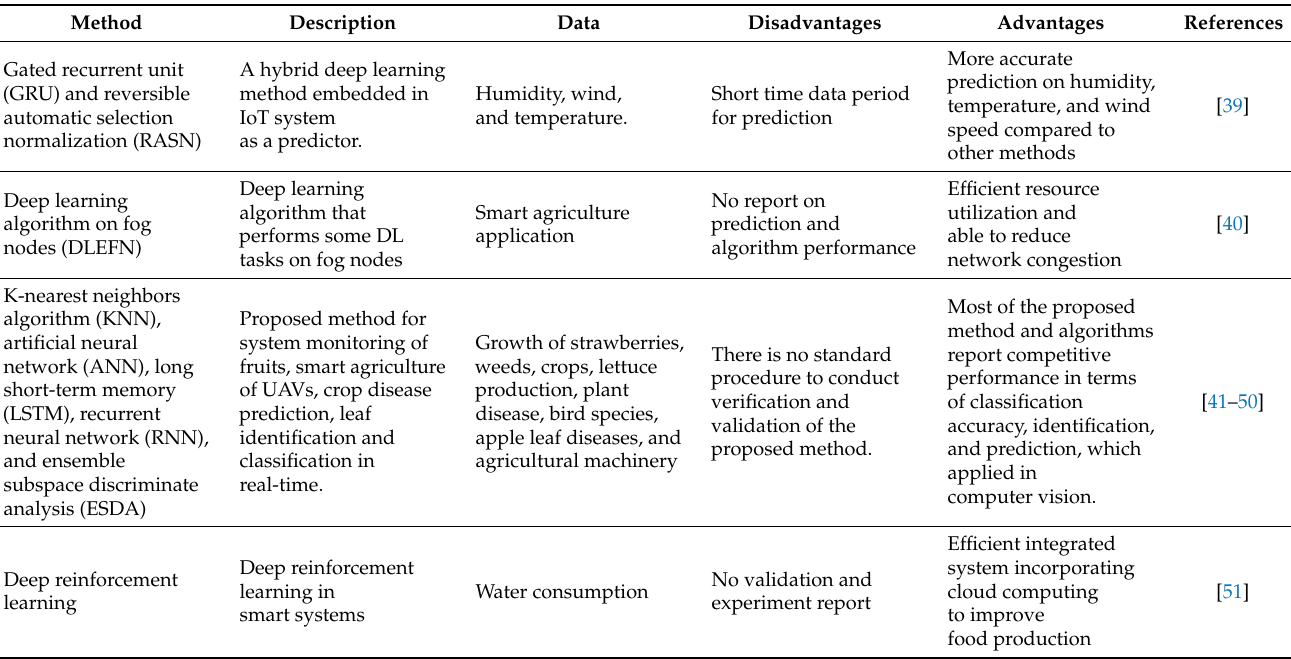
Table 7. Deep learning for smart agriculture.